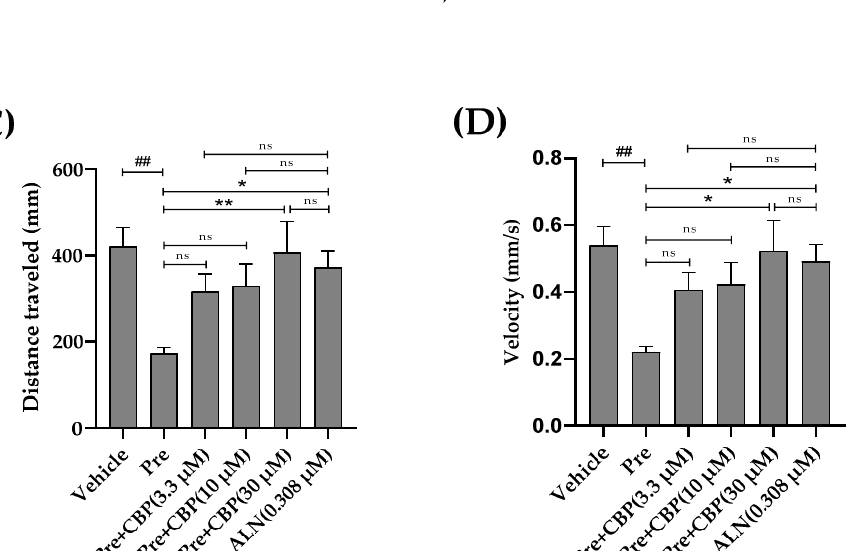
Figure 7. Effects of CBP on antiosteoporosis in the zebrafish model of GIOP. ( A ) Quantification of the relative fluorescence intensity (RFI) of the zebrafish skull at 7 dpf. ( B ) Representative fluorescence images of the zebrafish skull with different samples at 7 dpf ( a ) 0.1% DMSO (Vehicle), ( b ) 25 µ M prednisolone (Osteoporosis), or co-administered with CBP (3.3 µ M, 10 µ M, 30 µ M) ( c – e ), or 0.308 µ M alendronate (positive control) ( f ) for 96 h. ( C ) Distance traveled of zebrafish larvae at 96 hpf after exposure to CBP. ( D ) Swimming speed of zebrafish larvae at 96 hpf after exposure to CBP. n = 10. Data are expressed as mean ± SEM. ## p < 0.01 vs. vehicle, * p < 0.05, ** p < 0.01, and *** p < 0.001 vs. Pre, ns, not significant. (Pre, prednisolone; ALN, alendronate).